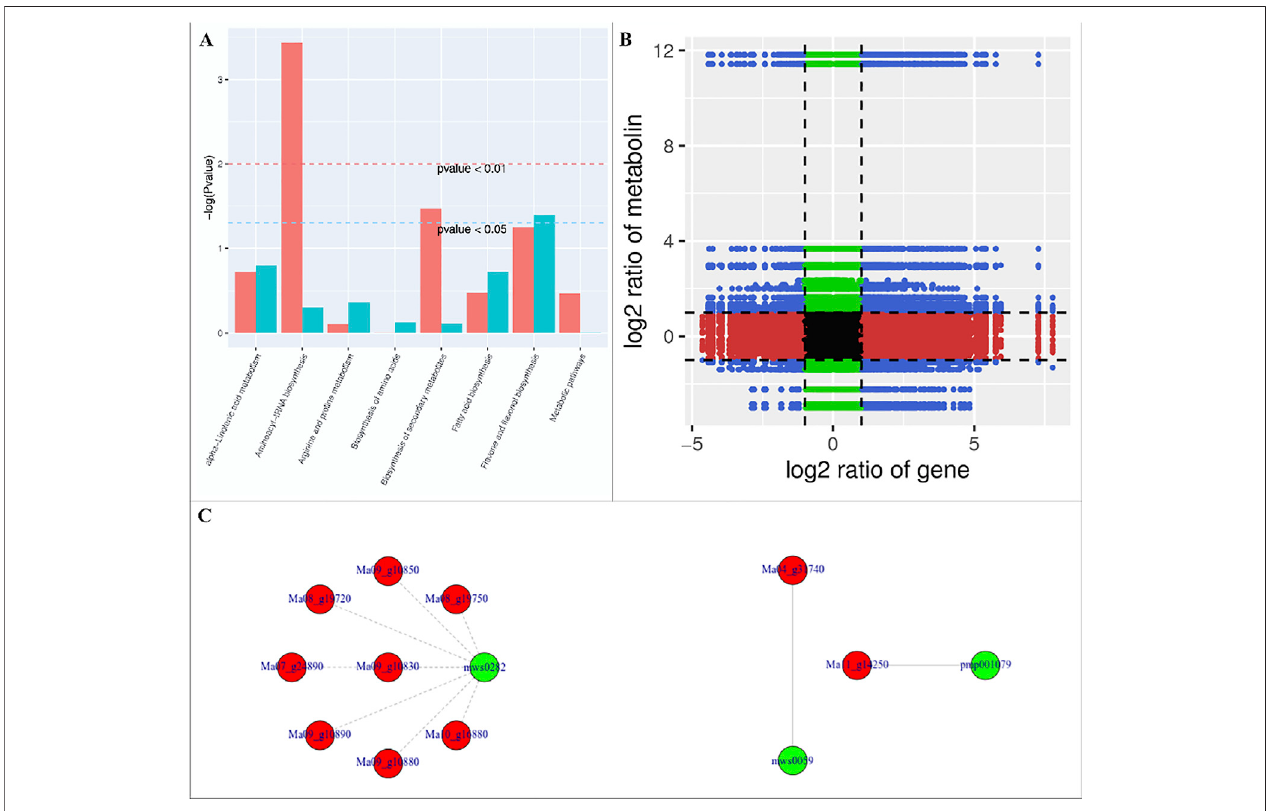
FIGURE 7 | (A) Co-joint analyses of DEGs and DAMs between UV-C treated M. nana and CK. (A) KEGG pathway enrichement, (B) nine-quadrant graph, and (C) network diagrams of DAMs and DEGs based on PCC ( ≥ 0.8).